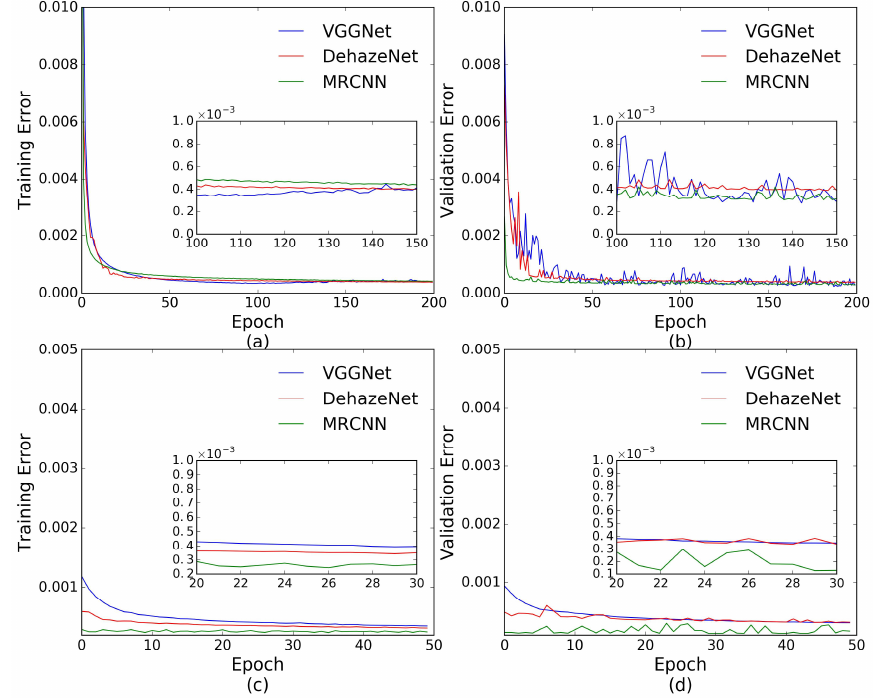
Figure 14. Learning curves for DehazeNet, VGGNet, and the proposed MRCNN. ( a , b ) training error and validation error on D1 during the original training process; ( c , d ) training error and validation error on D2 during the transferring application.